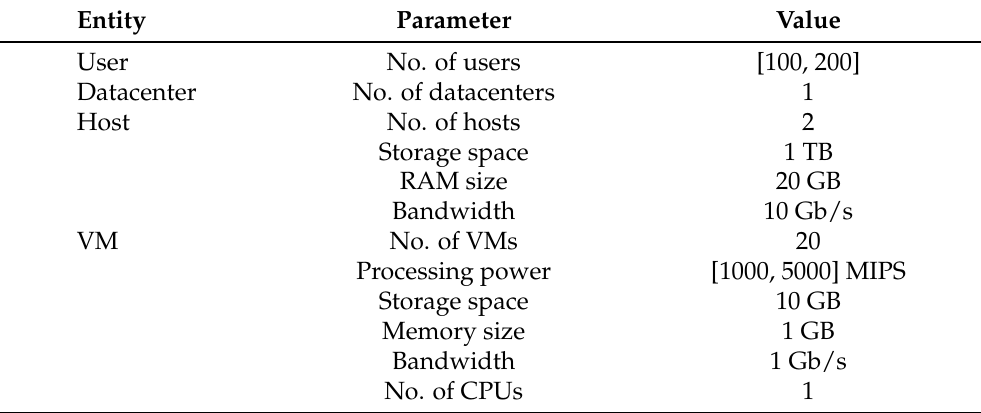
Table 9. Experimental parameter settings.